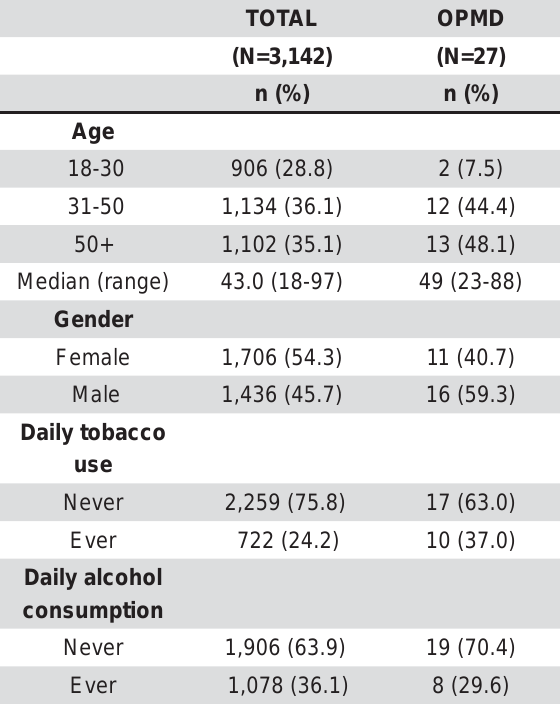
Table 1- Patients characteristics Table 2- Multivariate analysis for oral potentially